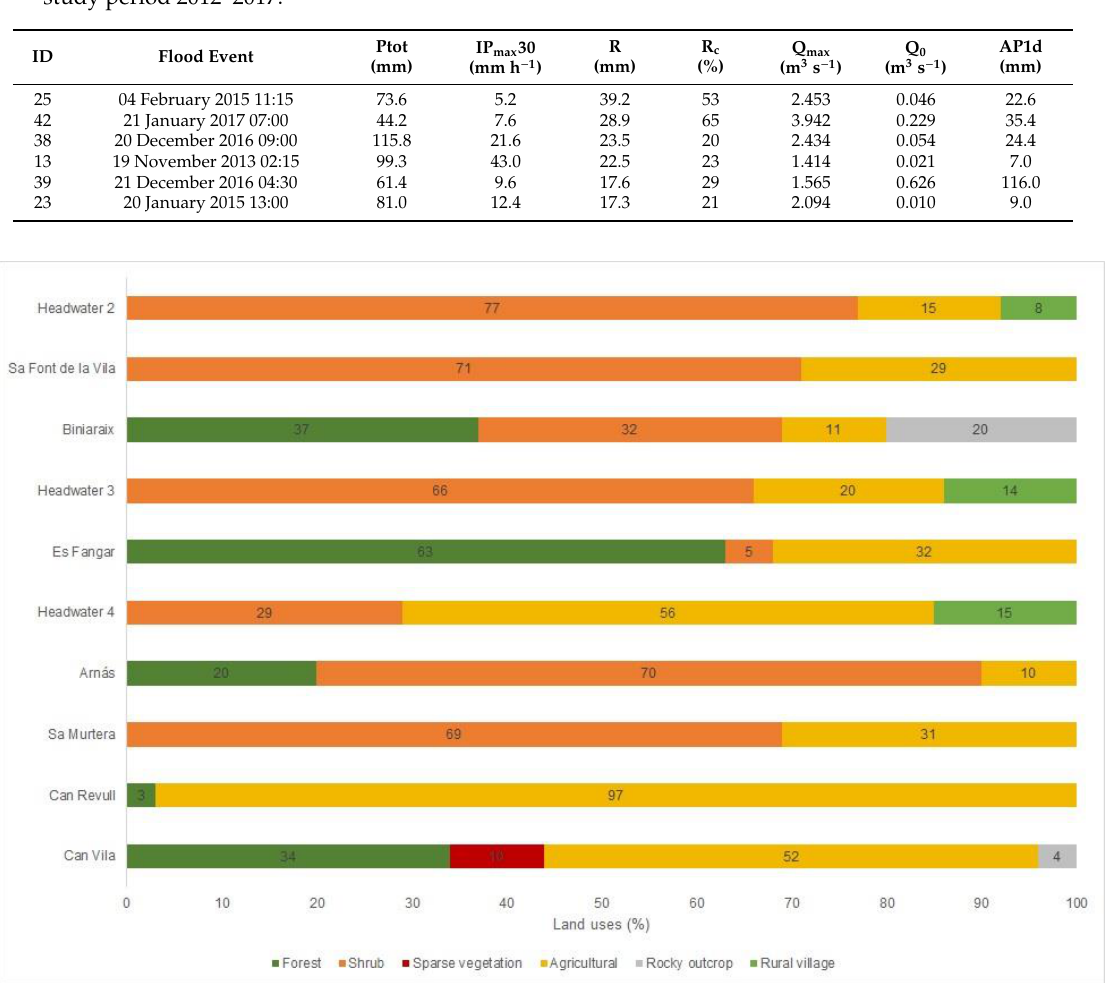
Table A4. Main characteristics of the selected events for non-linearity analysis in Es Fangar Creek.